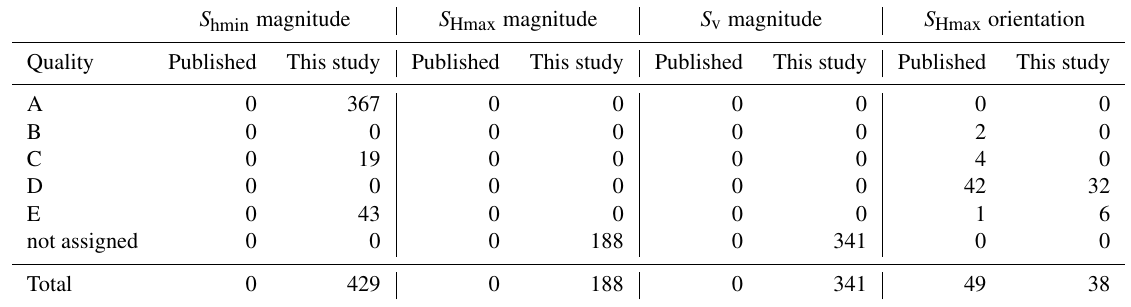
Table 4. Number of data records from the greater Ruhr region, including their quality assignment (based on Morawietz et al., 2020 and Heidbach et al., 2016), from this and already published studies. As the quality ranking scheme by Morawietz et al. (2020) allows only to determine quality of the S hmin magnitude, no quality was assigned to the magnitude estimates of S Hmax and S v